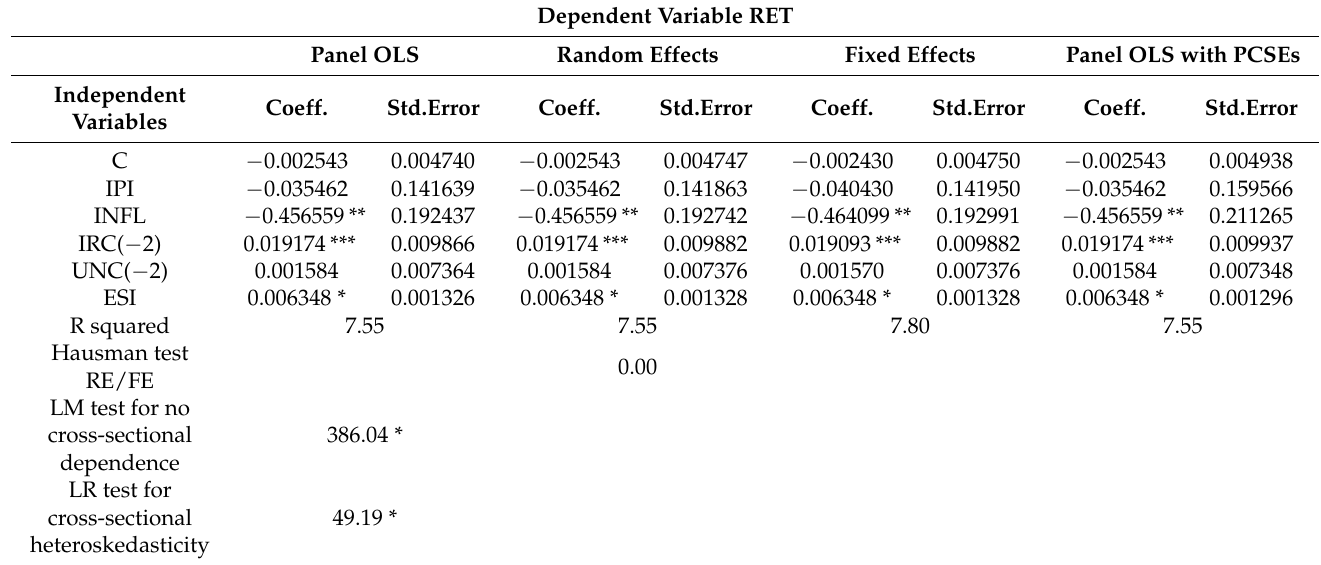
Table 5. Results for peripheral